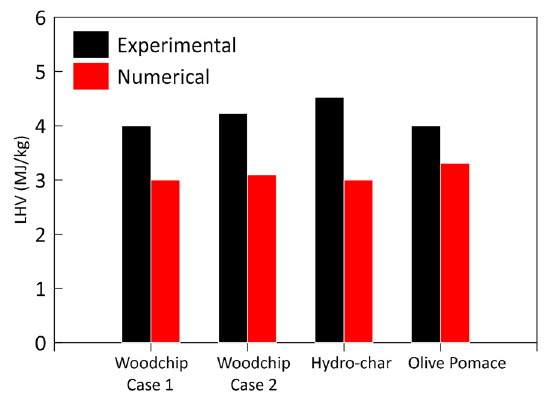
Figure 8. Histogram comparison between the measured and numerical syngas LHV for the four biomasses/residual materials tested.